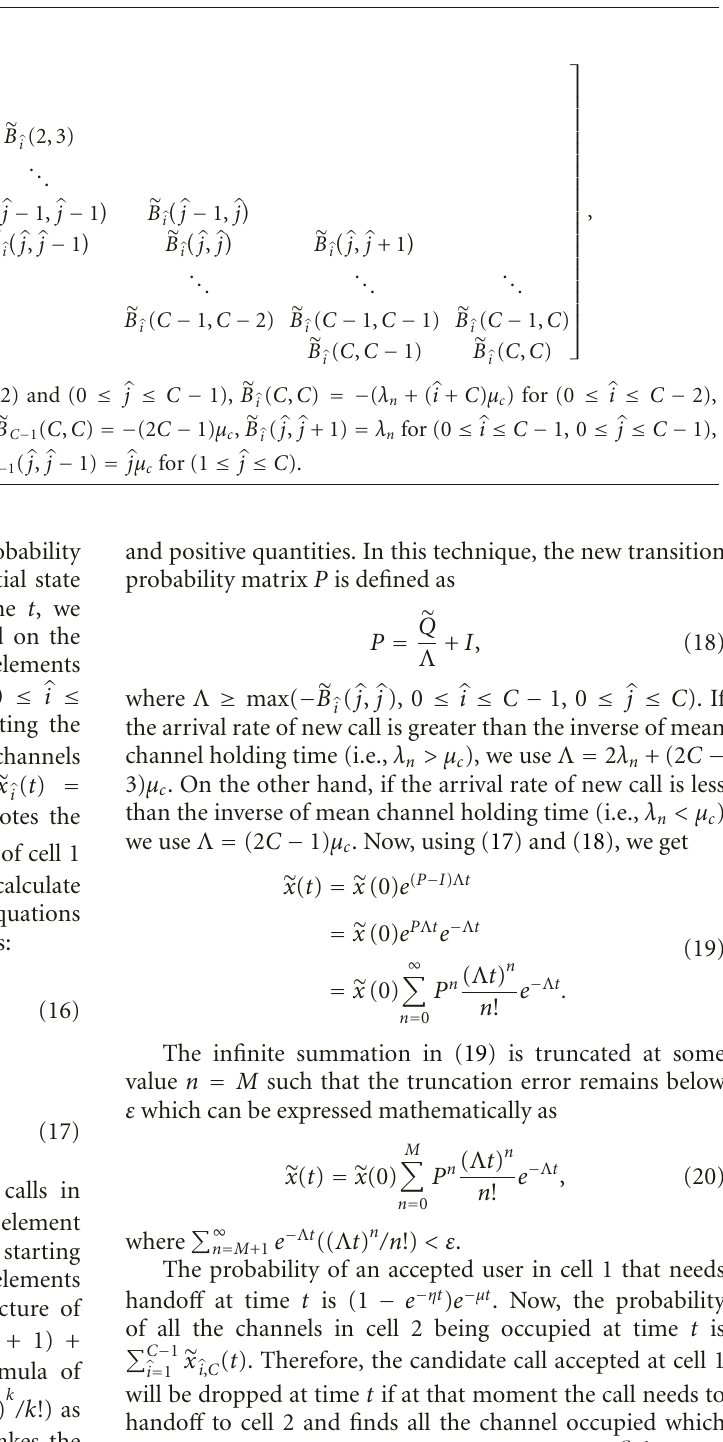
Table 2: Structure of (cid:17) B (cid:16) in adaptive call admission control scheme for two-cell i